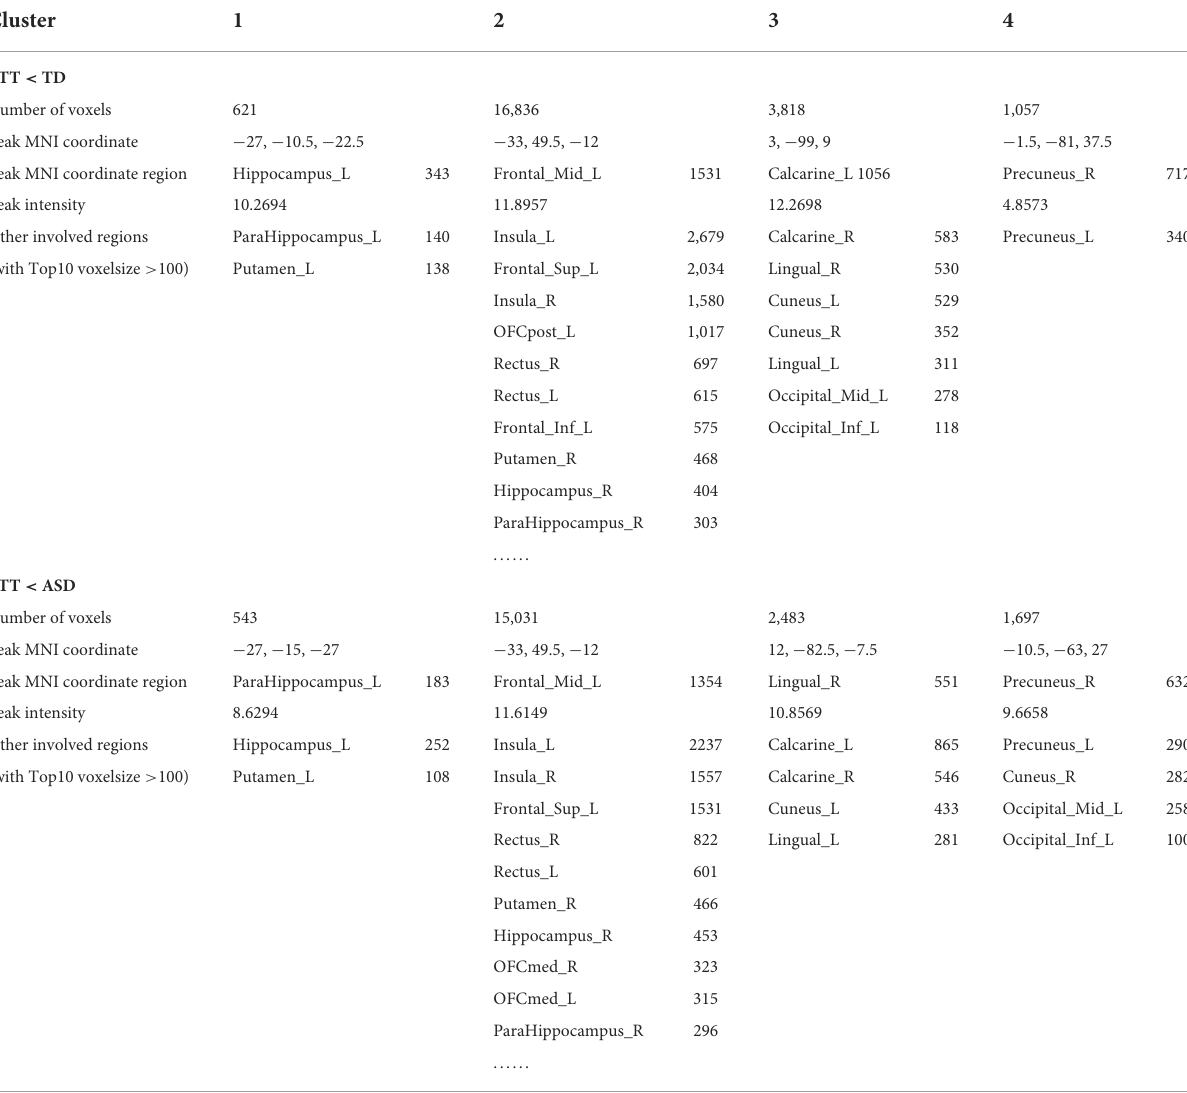
TABLE 2 Decreased gray matter volumes in comparisons between RTT group and controls for VBM